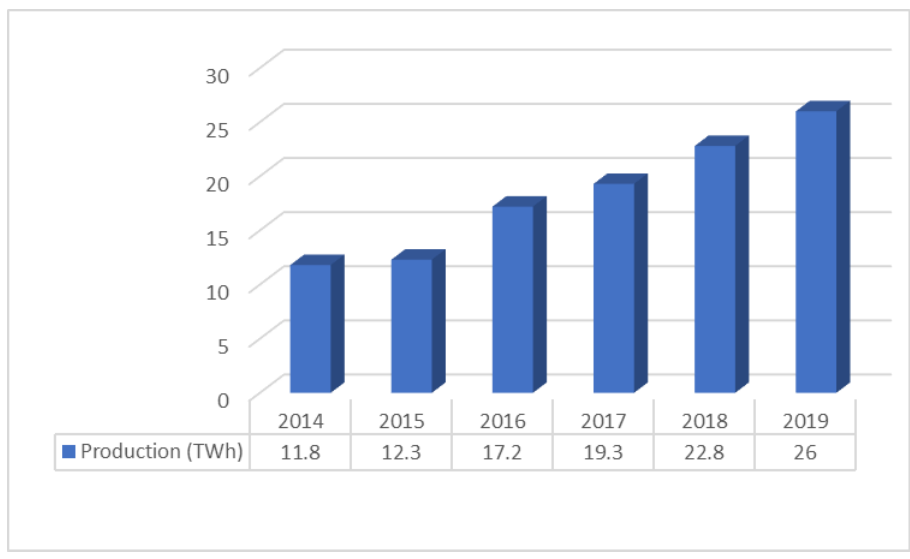
Figure 1 . Biomethane production in Europe.